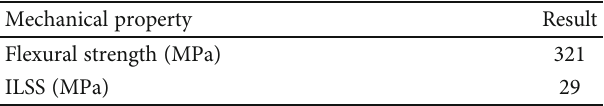
Table 2: Mechanical properties of MDPES-2 composite.